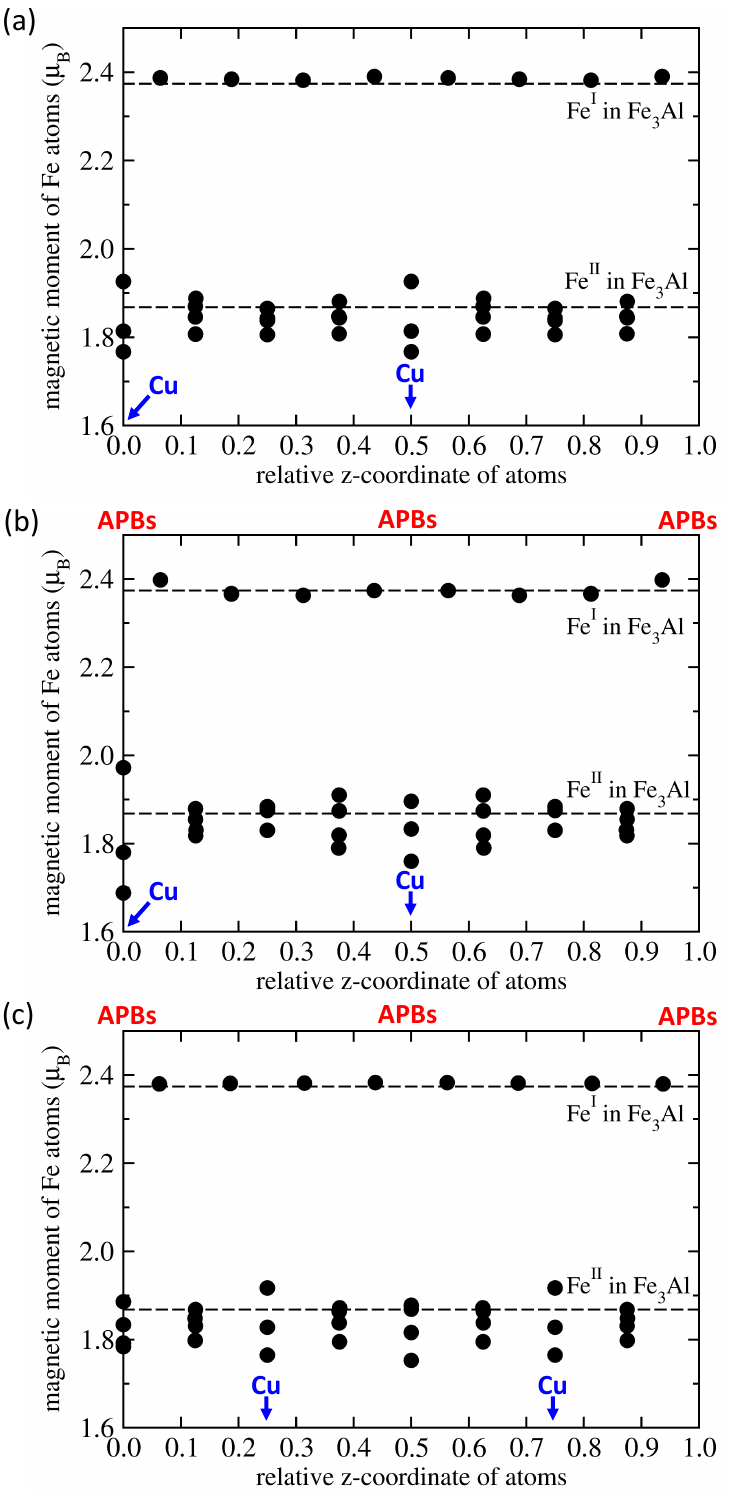
Figure 2. Calculated local magnetic moments of iron atoms in Fe 3 Al with Cu substituents without antiphase boundaries ( a ), with Cu atoms located at the interface of the studied antiphase boundaries ( b ), and with the Cu substituents away from the APBs ( c ). The magnetic moments are compared with values for the Cu-free and defect-free bulk Fe 3 Al (horizontal dashed